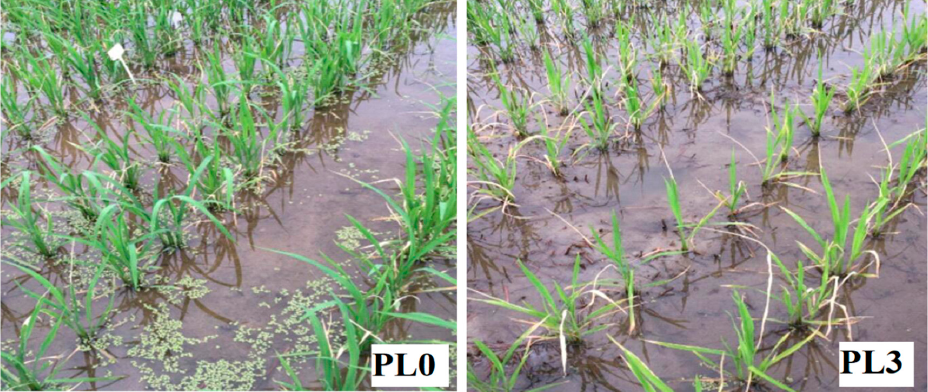
Figure 1. Dynamic changes of rice tillers without straw treatment (PL 0 ) and under straw treatments (PL 3 ).